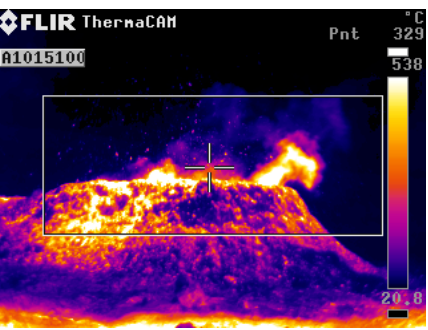
Figure 2. Temperature ( ◦ C) of the October 2010 eruption of PdF through infrared imagery provided by OVPF. The temperature scale (right colour bar) ranges between 20.8 and 538 ◦ C. As approximate spatial scale in this image, the crater diameter is about 25m. (The temperature indication in the upper right corner corresponds to the central pixel marked as a